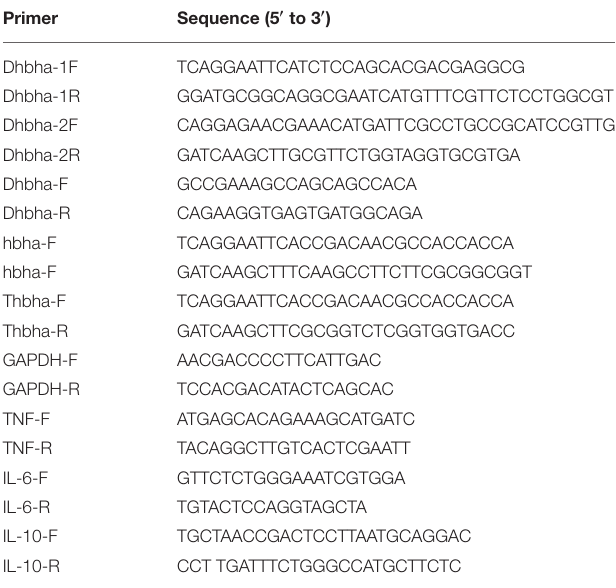
TABLE 1 | Primers used for PCR and